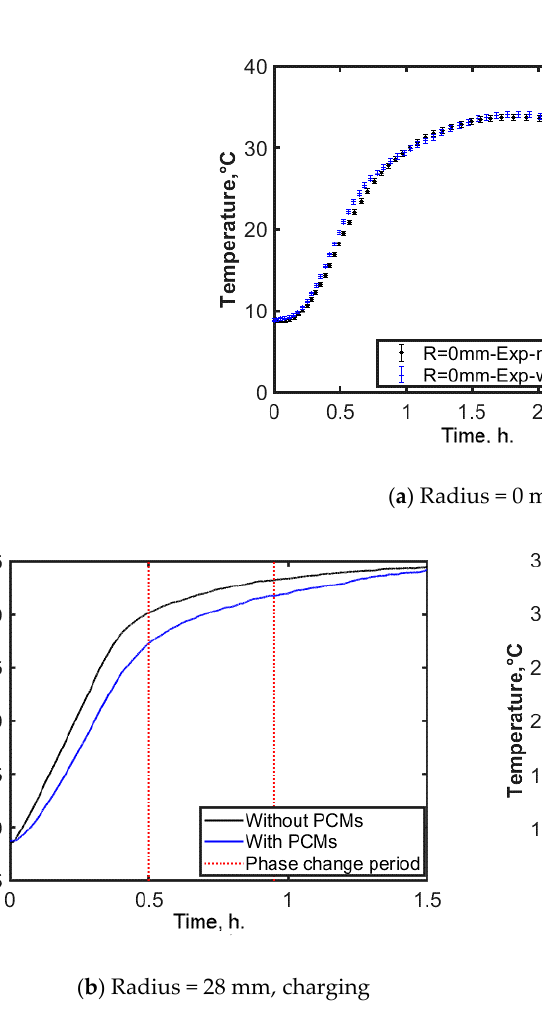
Figure 13. Temperature distributions inside the concrete at different radius for Q = 1471 mL/min.